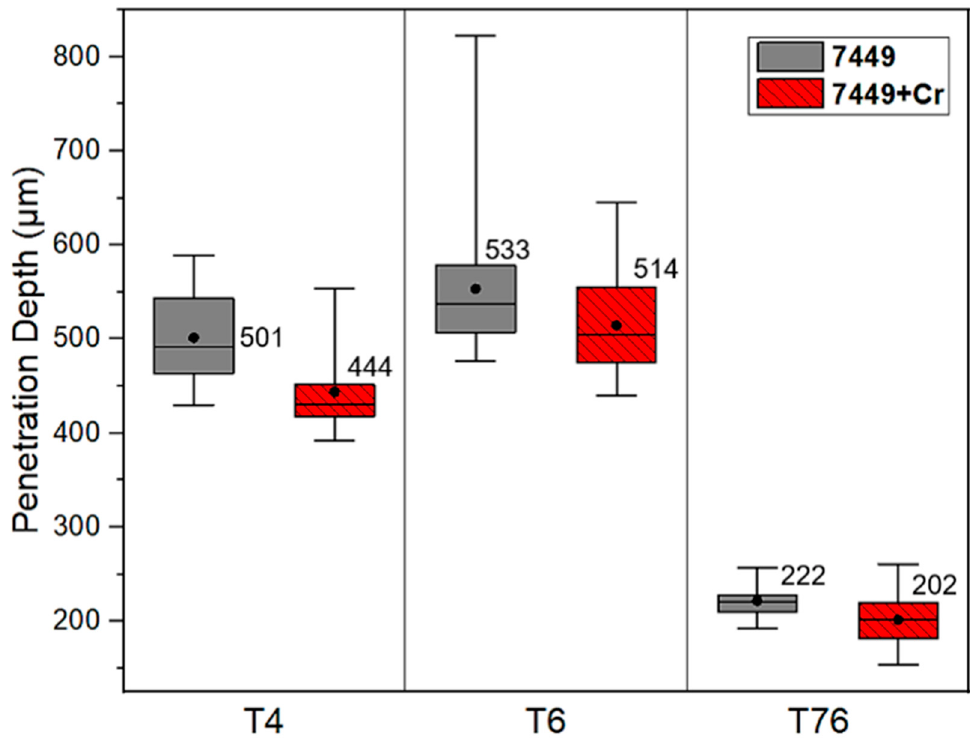
Figure 17. Box plots of measured corrosion penetration depth after 24 h immersion in a pH 1 IGC solution. The black circles and values indicate the average penetration depth. solution. The black circles and values indicate the average penetration